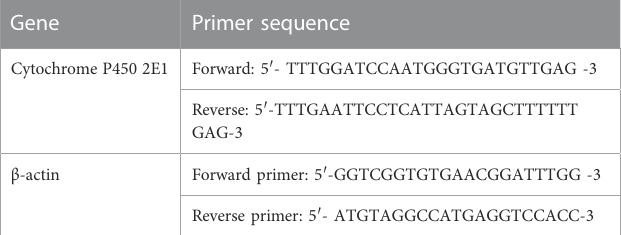
TABLE 1 Primer sequence of the studied rat genes. Gene Primer sequence Cytochrome P450 2E1 Forward: 5 ′ - TTTGGATCCAATGGGTGATGTTGAG -3 Reverse: 5 ′ -TTTGAATTCCTCATTAGTAGCTTTTTT GAG-3 β